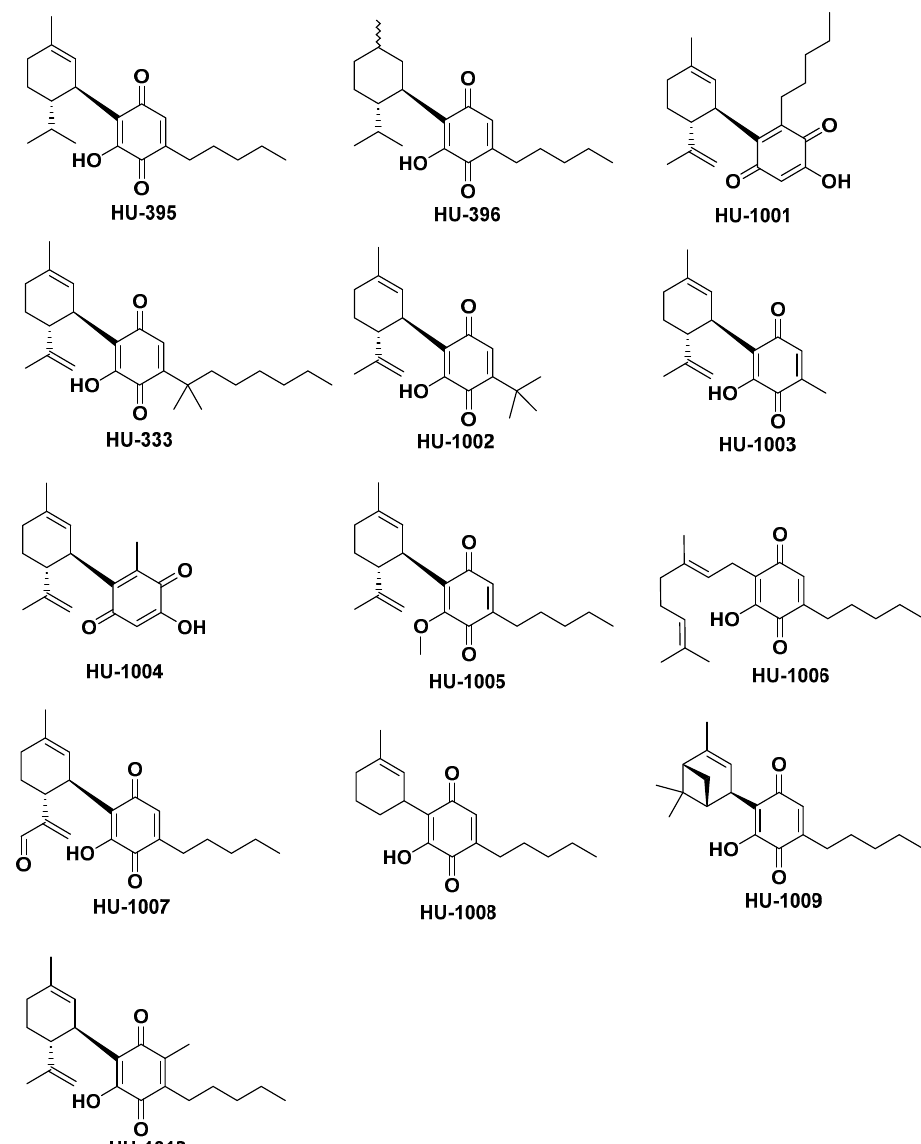
Figure 2. HU-331-like compounds synthesized in this study.